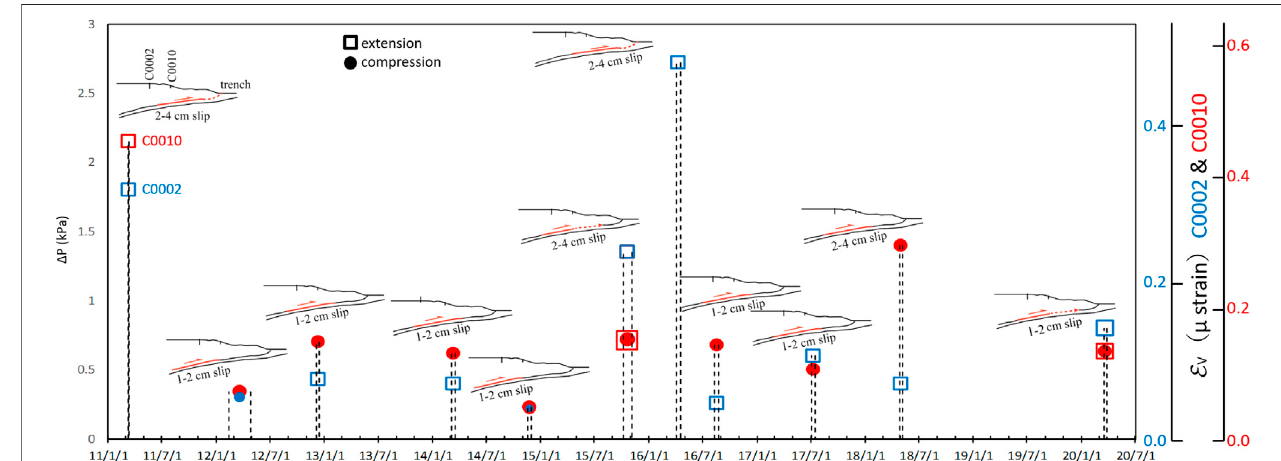
FIGURE 10 | Updatedsummaryofthetransientsinporepressure( Δ P)andvolumetricstrain( ε v )attheC0002(blue)andC0010(red)boreholescollatedafterArakietal.(2017) ( Table 2 ).TheSSEin2020isassumedtobeCasesA-1and A-2in Table 5 . Theverticaldashedlinesindicatetheduration ofeach SSE.Theopensquareand solid circlerepresent extension and compression, respectively. The schematic cross-sections for each SSE are based on the catalog ( Table 2 ), where the red region represents the slip region.